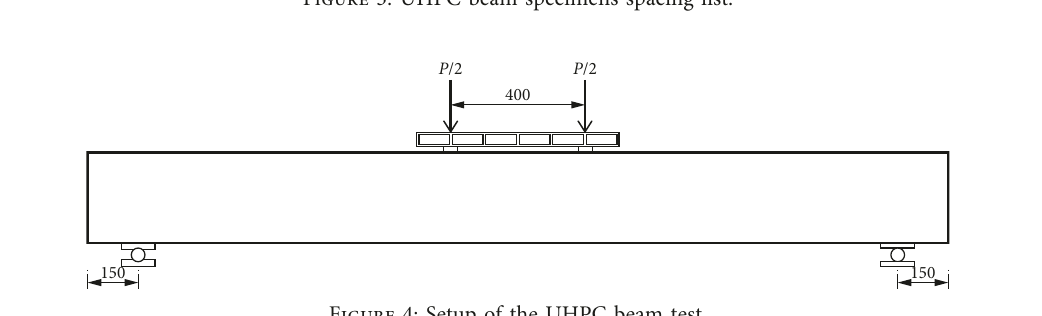
Figure 3: UHPC beam specimens spacing list.